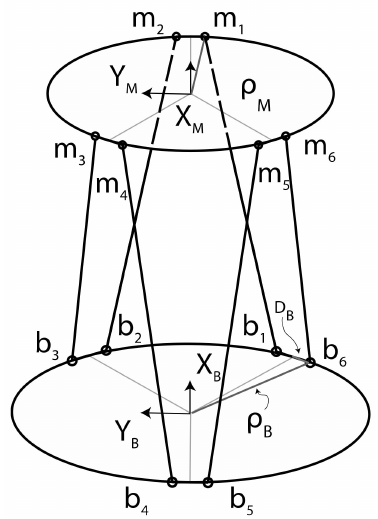
Figure 3. Platform geometric scheme with frame assignments and connecting points. The frame {B} is the reference frame assigned to the base plate, while the frame {M} is attached to the moving plate. Points b i and m i are the connecting points of the legs which connect the base to the mobile